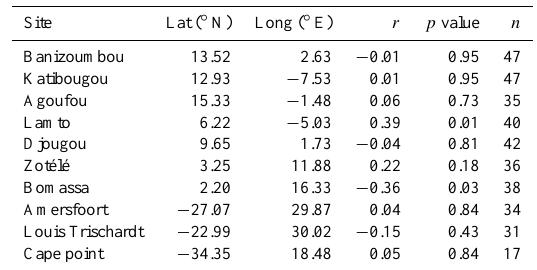
Table A3. Statistical analysis of the IDAF data set and monthly IASI satellite surface concentrations comparison for each stations during 2008, 2009, 2010 and 2011. Each site is characterized by its name and coordinates, its Pearson’s correlation coefficient ( r ) and the associated p value as well as its number of points ( n ). Only monthly values with a relative IASI retrieval errors below 100% have been taken into